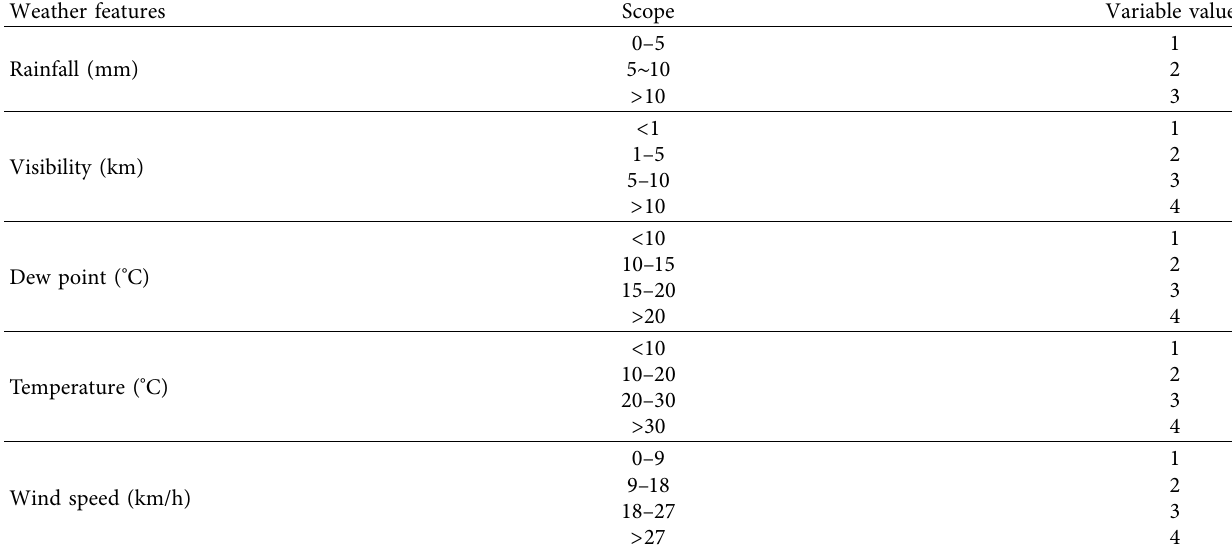
Table 3: Weather features and their values.